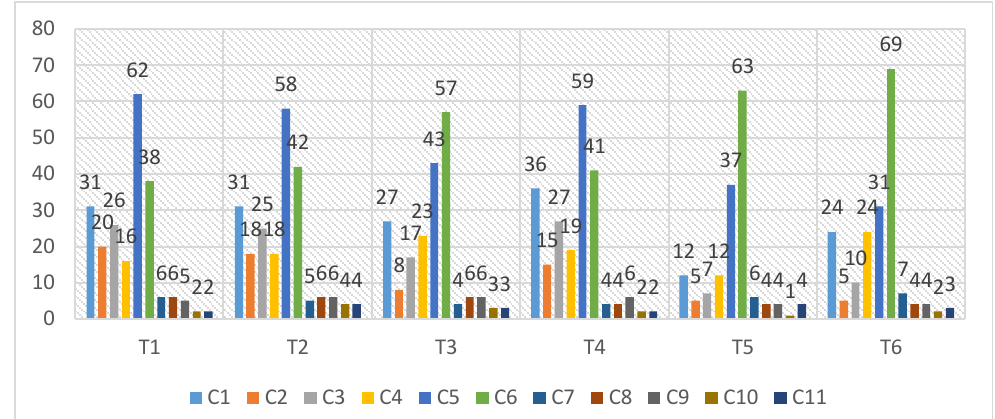
Fig. 1. Graphical representation of the above mentioned data.